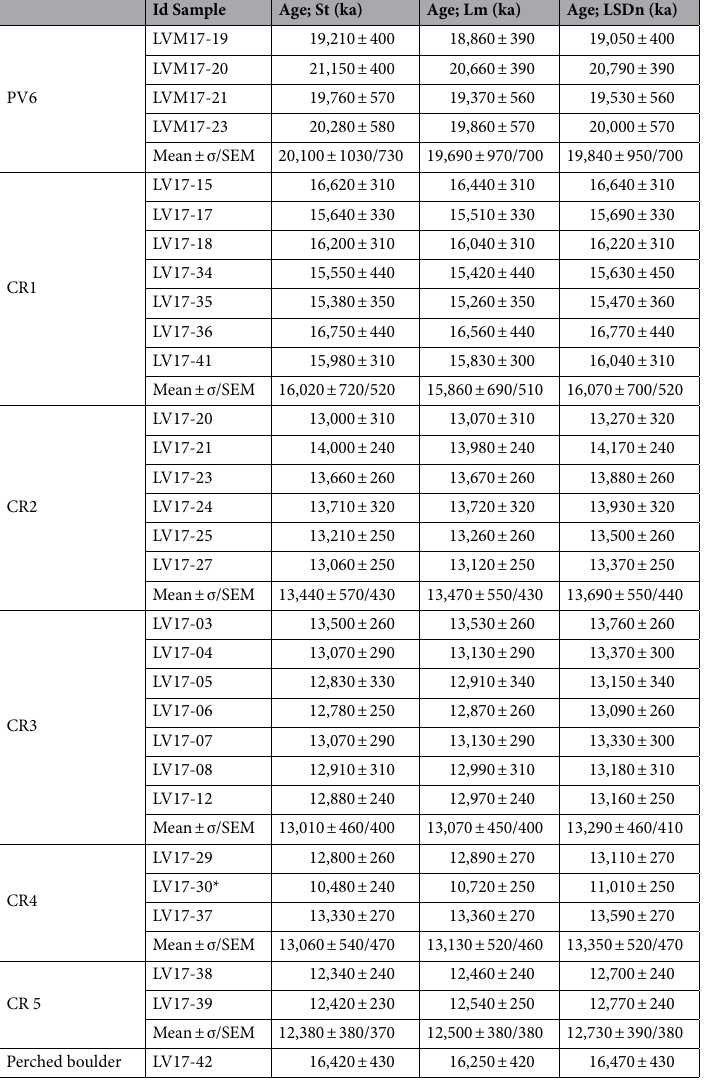
Lal/Stone scaling scheme (St; 21,22 ) time-dependent Lal/Stone scaling (Lm; 21,22 and Lifton et al. scaling (LSDn; 64 ). Mean moraine ages are shown in bold with 1 outlier excluded (*), and are accompanied by the uncertainty (1 standard deviation [σ]/Standard Error of the Mean [SEM]) considering the propagated error (3%) of the production rate 20 for